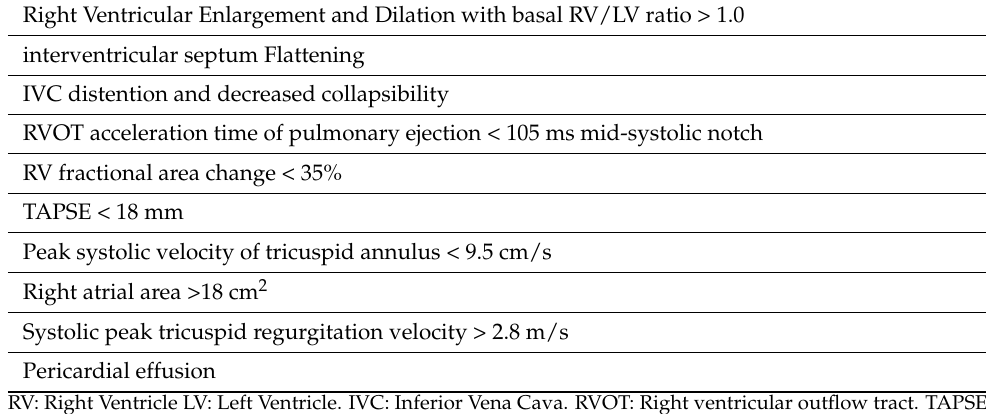
Table 1. Transthoracic Echocardiographic Findings in Pulmonary Hypertension. Right Ventricular Enlargement and Dilation with basal RV/LV ratio >